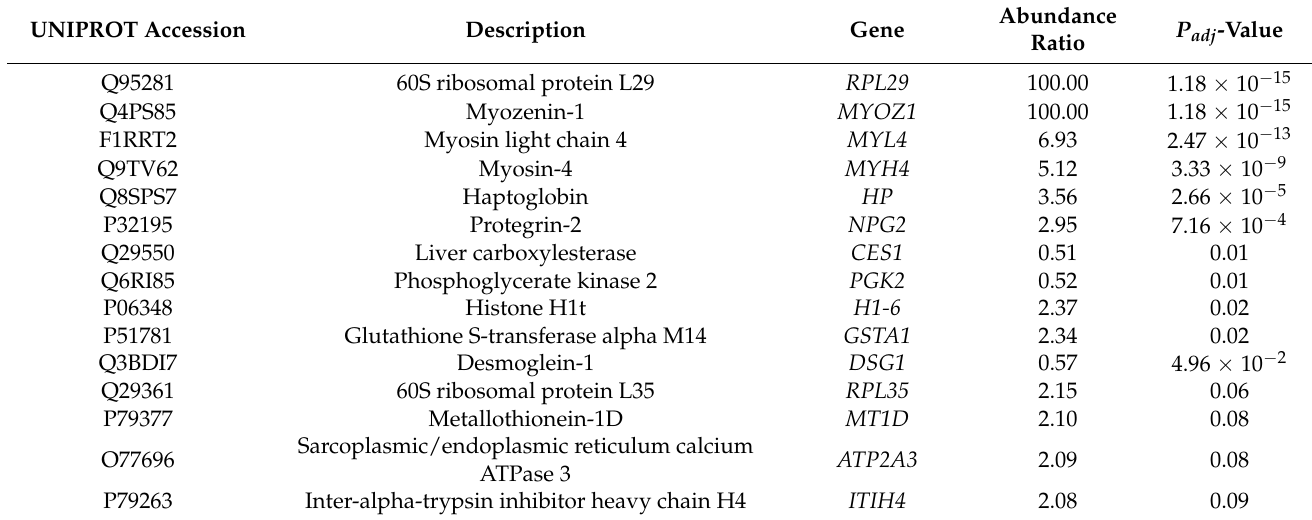
Table 4. Differentially expressed proteins * from adipose tissue, protein-coding genes, and their abundance ratio